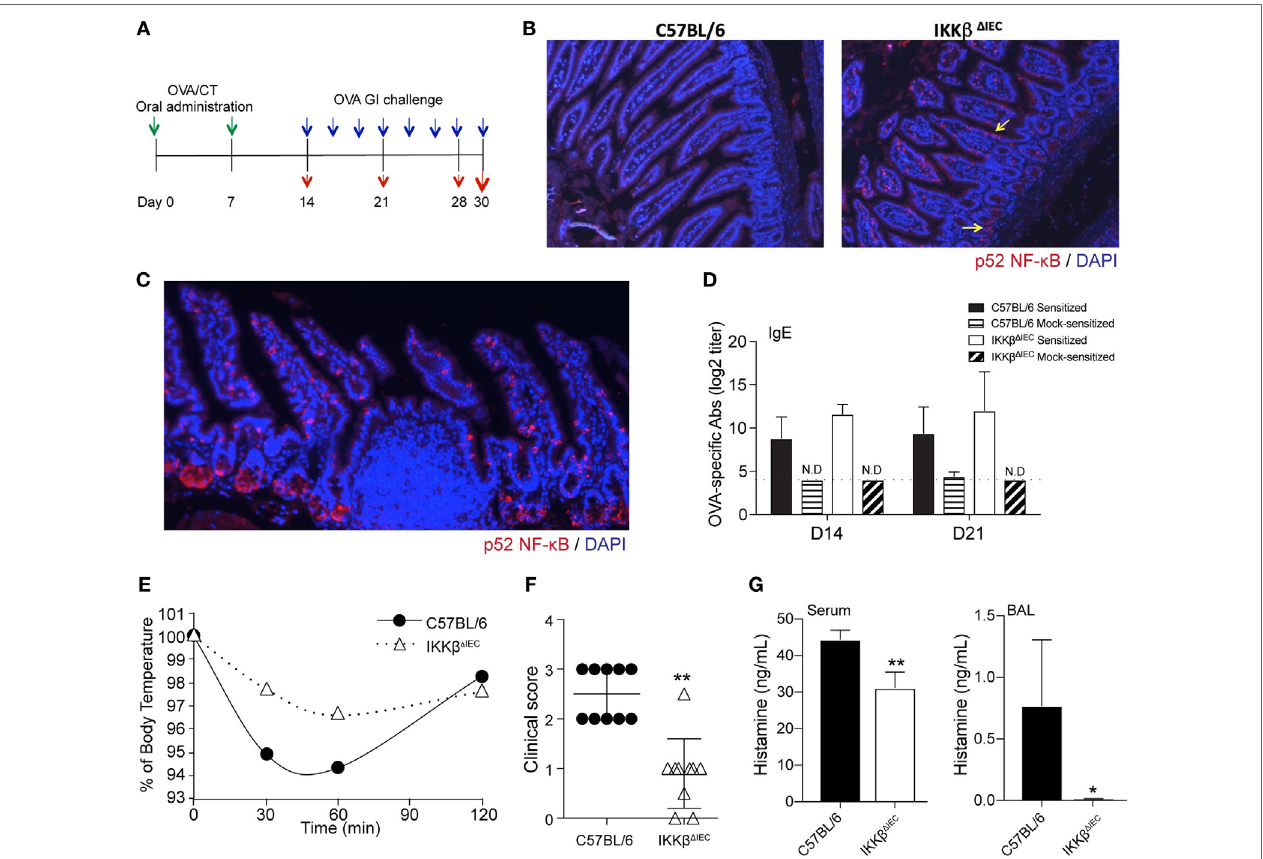
FigUre 1 | Mice with selective IKK β -deficiency in intestinal epithelial cells have lower clinical signs of allergy after oral allergen challenge. (a) Experimental scheme. Wild-type C57BL/6 and IKK β Δ IEC mice were orally sensitized by ovalbumin (OVA) allergen and cholera toxin (CT) as adjuvant (green arrows), and then orally challenged with OVA (blue arrows). Serum or lung tissues were collected at days 14, 21, 28, and 30 to analyze antibodies responses or clinical signs of allergy (red arrows). (B) Expression of the non-canonical NF- κ B pathways in the intestine of naïve wild-type C57BL/6 and IKK β Δ IEC mice and (c) expression of the non-canonical NF- κ B pathways in intestinal villi, crypts, and Peyer’s patches of IKK β Δ IEC mice. Sections of small intestinal tissues were stained with an anti-p52 NF- κ B antibody and counterstained with DAPI to visualize the nuclei. (D) Allergen-specific serum IgE. Mice were sensitized by oral administration of OVA (1 mg) and CT (15 µg). Serum samples were collected on days 14 and 21 and OVA-specific IgE titers were determined by enzyme-linked immunosorbent assay (ELISA). The results are expressed as mean log 2 titers ± 1 SD and are from at least five experiments and five mice/group. (e) Variation (%) of surface body temperature after oral challenge with OVA (50 mg) on day 30. (F) Clinical scores. Mice were orally challenged with OVA (50 mg) and clinical scores recorded according to the behavior criteria described in Section “Materials and Methods.” (g) Histamine levels after nasal allergen challenge with OVA on day 30. Serum and BAL samples were collected 2 h after allergen challenge and histamine levels measured by ELISA. Data are expressed as mean ± SD. * p < 0.05; ** p <